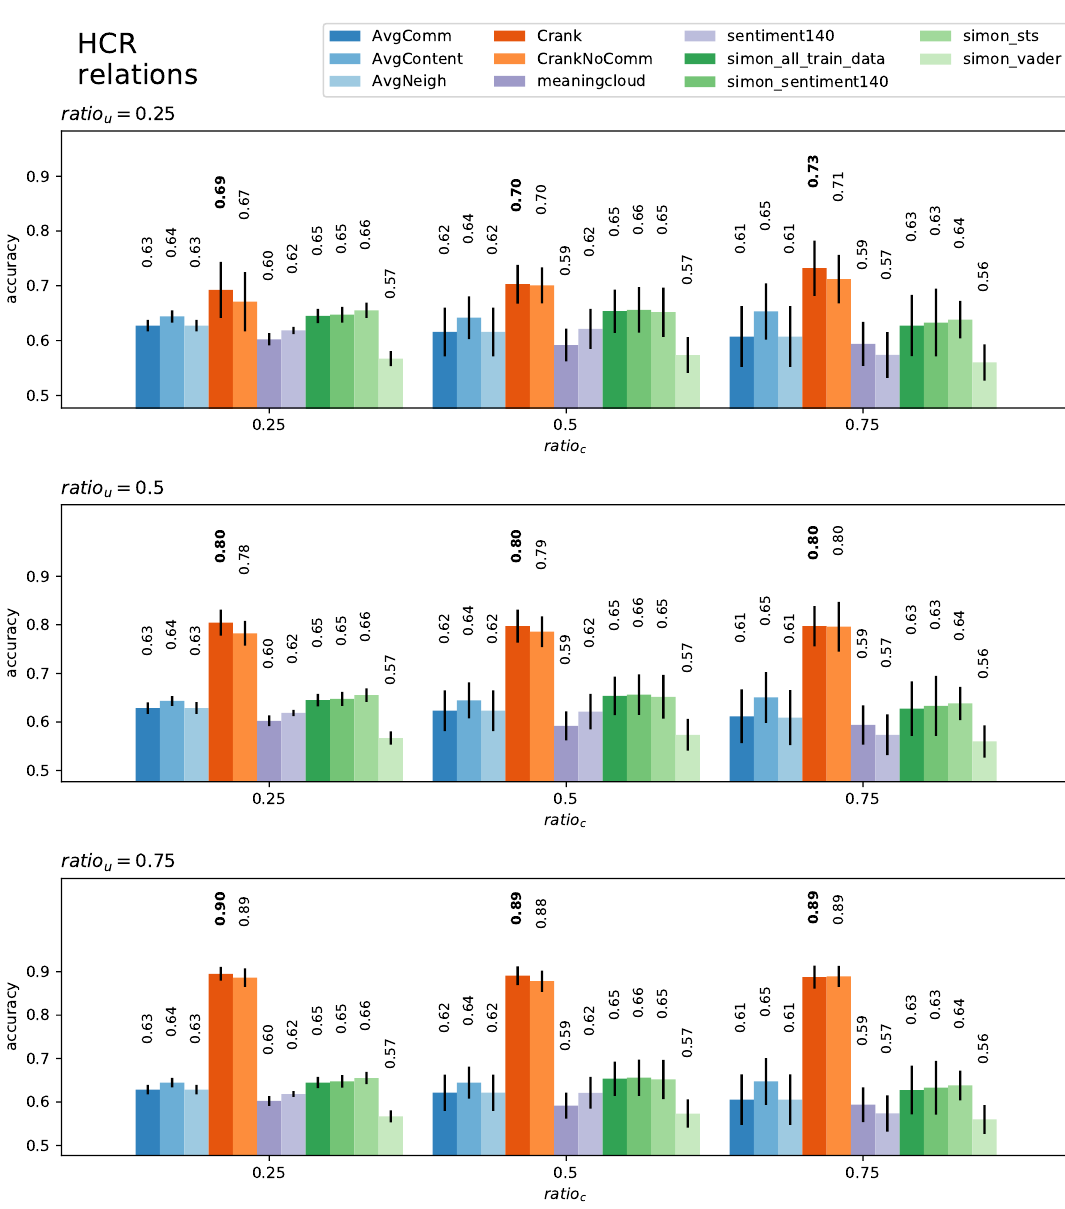
Figure 3. Content-level classification mean accuracy and standard deviation in the HCR dataset for each model at each level of certainty ( ratio u and ratio c )